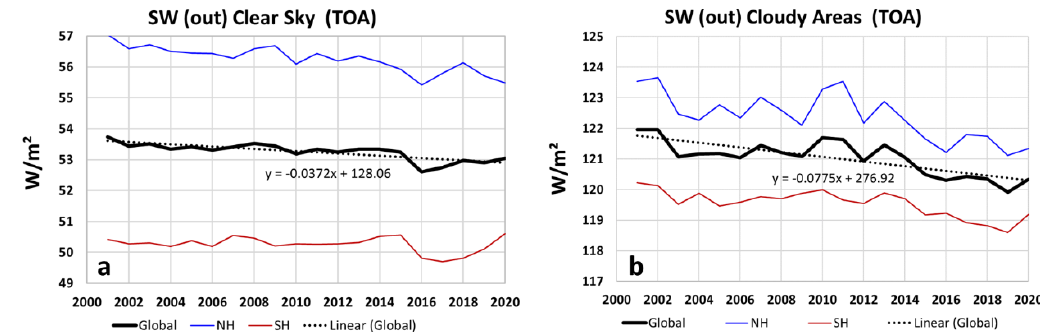
Figure 5. Shortwave outgoing radiative flux (TOA) over “Clear Sky” ( a ) and “Cloudy Areas” ( b ) for global average, NH, and SH. Please note, there is an apparent inconsistency when comparing these plots with Figure 3, in which there is no significant difference between NH and SH. The reason is a different average cloud area fraction of about 70% in the South and 64% in the North. Therefore, the cloud-area-weighted “All Sky” data are very similar.